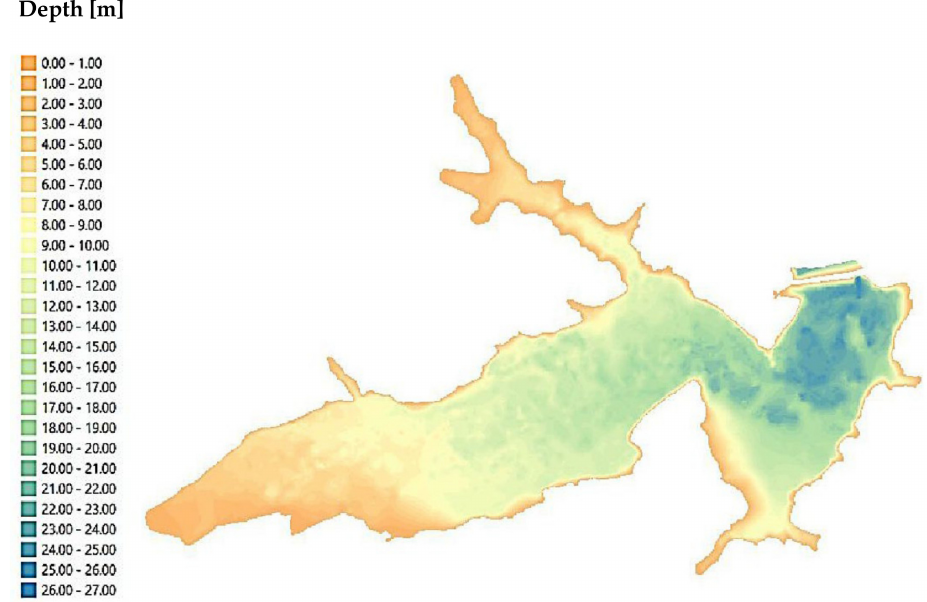
Figure 5. Depth map of Lake